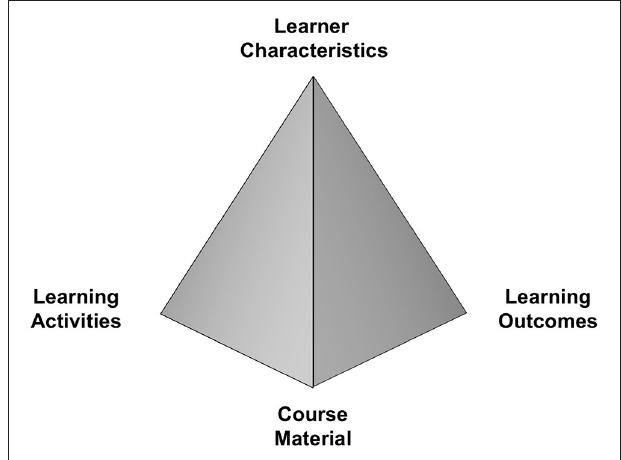
FIGURE 1 | A tetrahedral model of classroom learning (adapted from Jenkins,